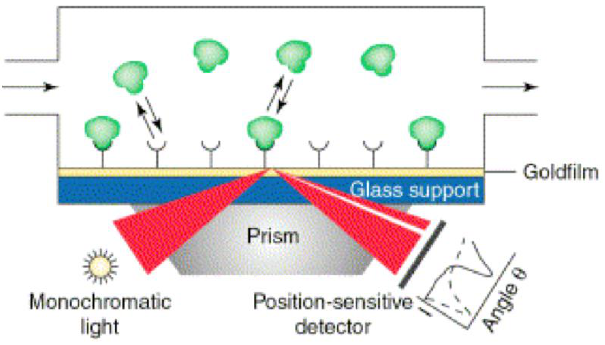
Figure 4. Schematic diagram of the surface plasmon resonance (SPR). Monochromatic light is reflected on a gold surface. At a certain angle, where the surface plasmons are excited, the reflected light has a minimum, which is continuously measured. This angle is directly connected with the analyte bound to the surface. Reprinted from [1] with permission from Elsevier.